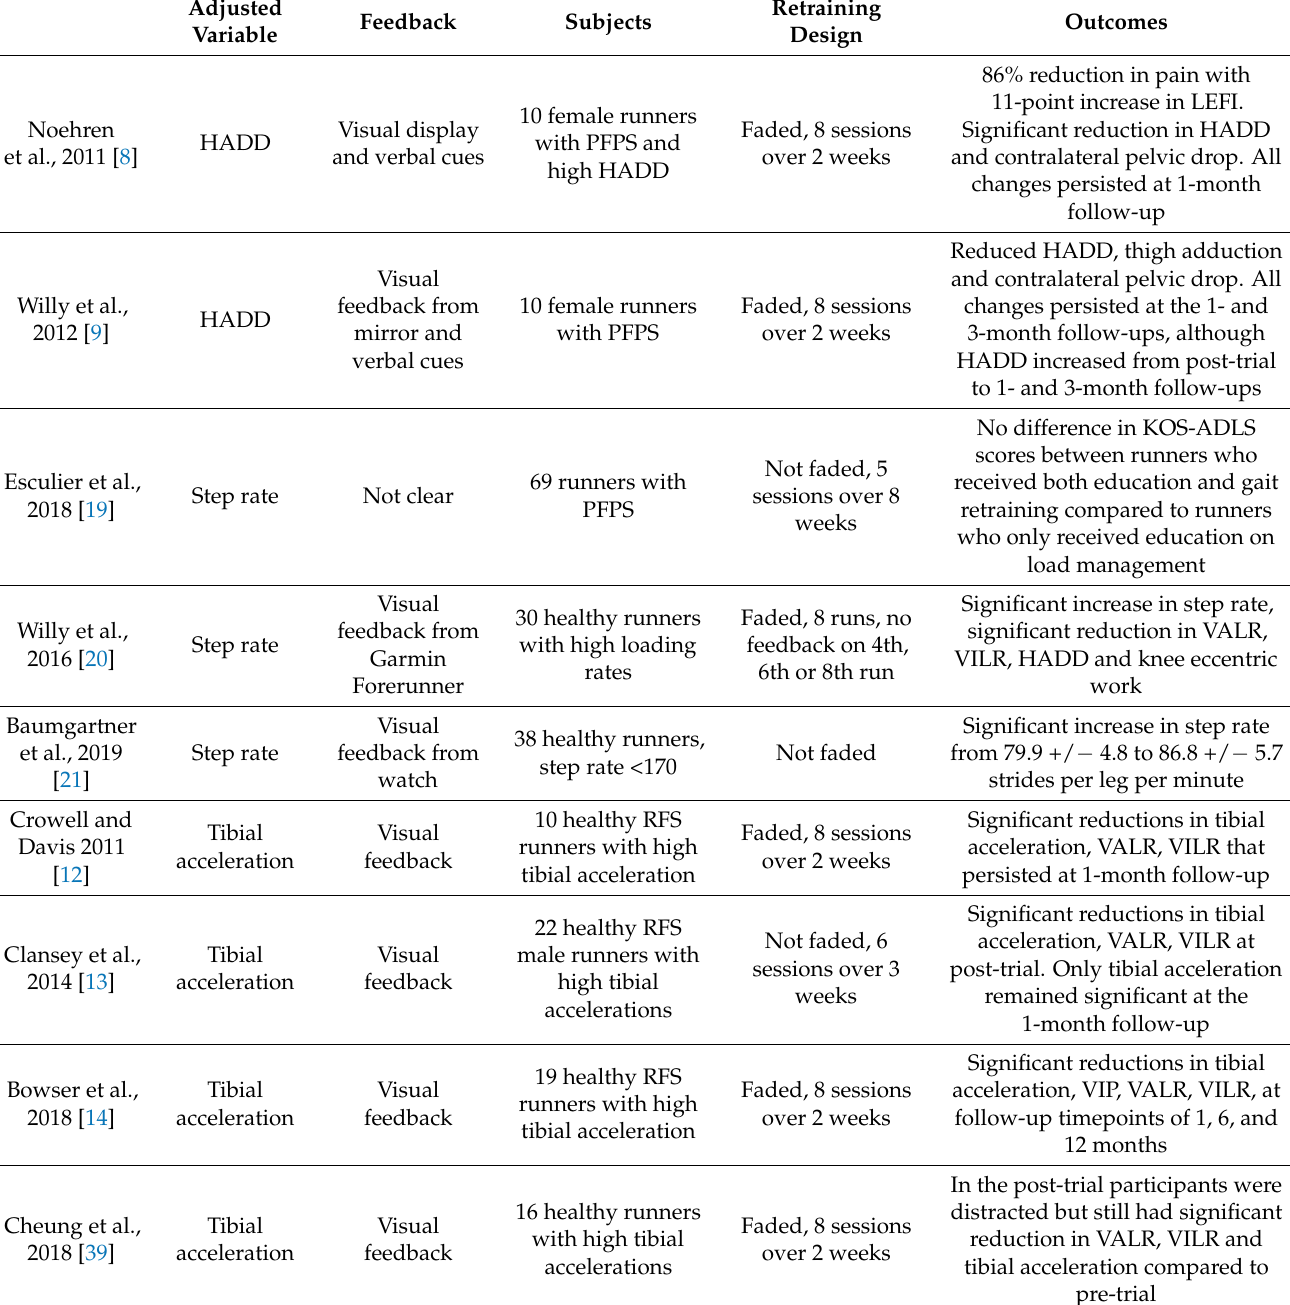
Table 2. Overview of Gait Retraining